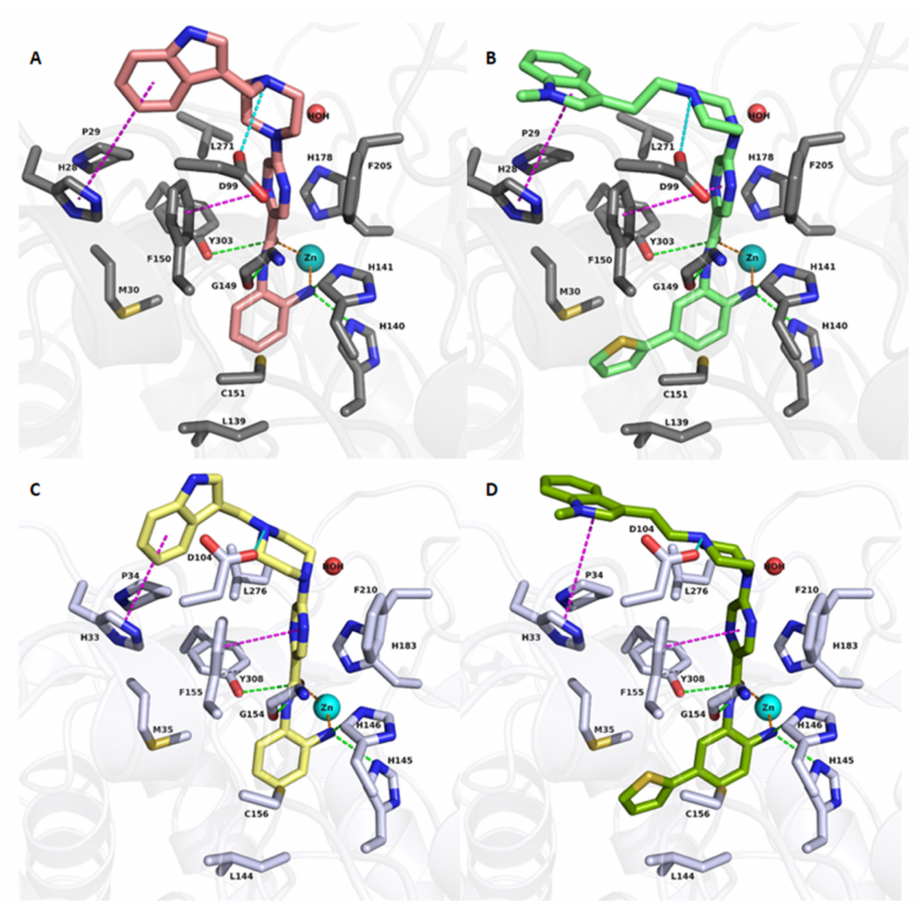
Figure 3. Docking poses of 19f ( A , salmon colored sticks), 21a ( B , light green colored sticks), in HDAC1 (PDB ID 4BKX), 19f ( C , yellow colored sticks), 21a ( D , dark green colored sticks), in